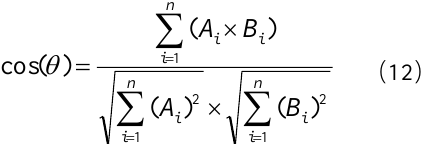
Figure 7. Flow chart of fingerprint recognition